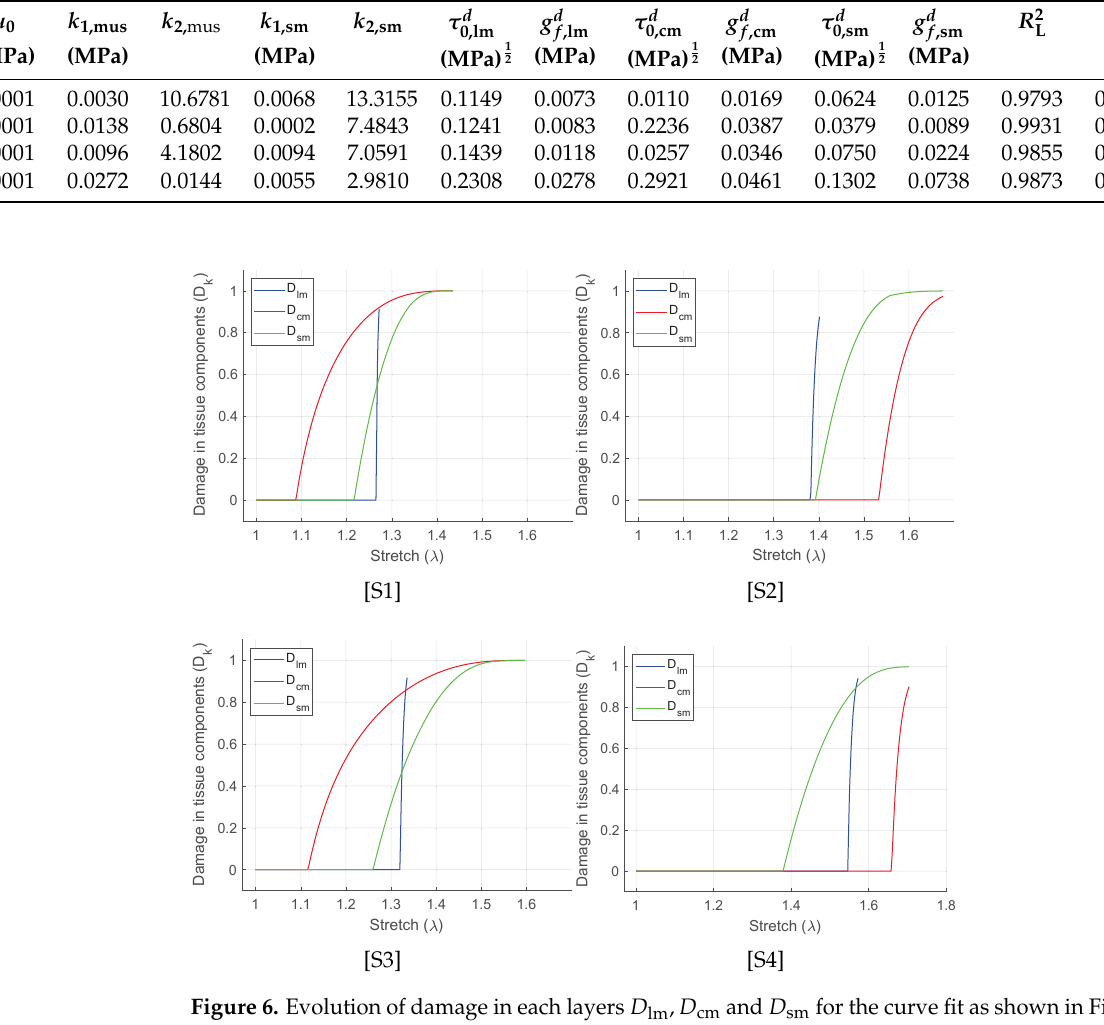
Table 1. Fitted values of anisotropic HGO material parameters including damage.